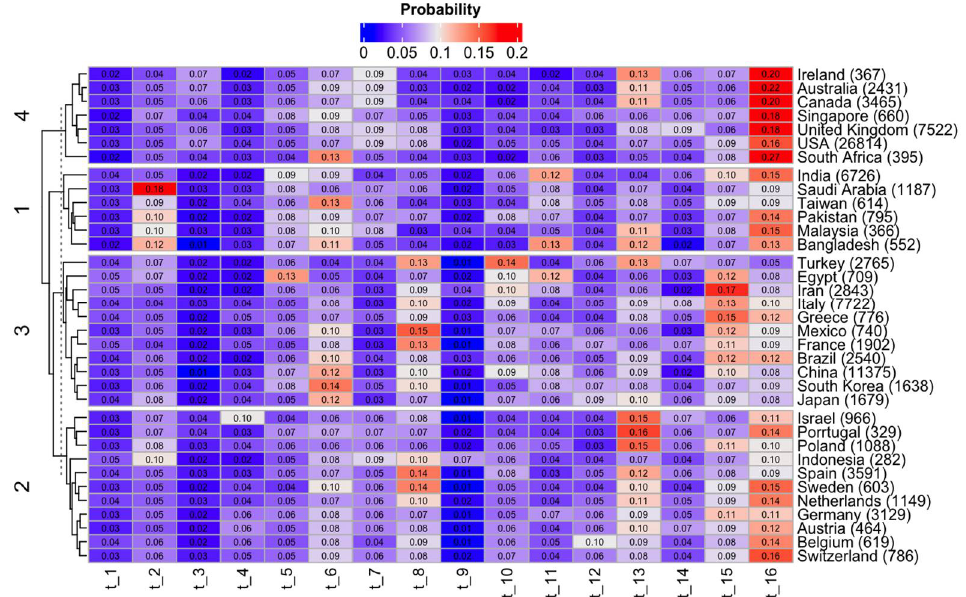
Figure 5. Heatmap overview of the proportional topic in the top-35 analyzed countries. Values are in percentages and row totals sum up to 100%. In parentheses, the number of articles is shown.